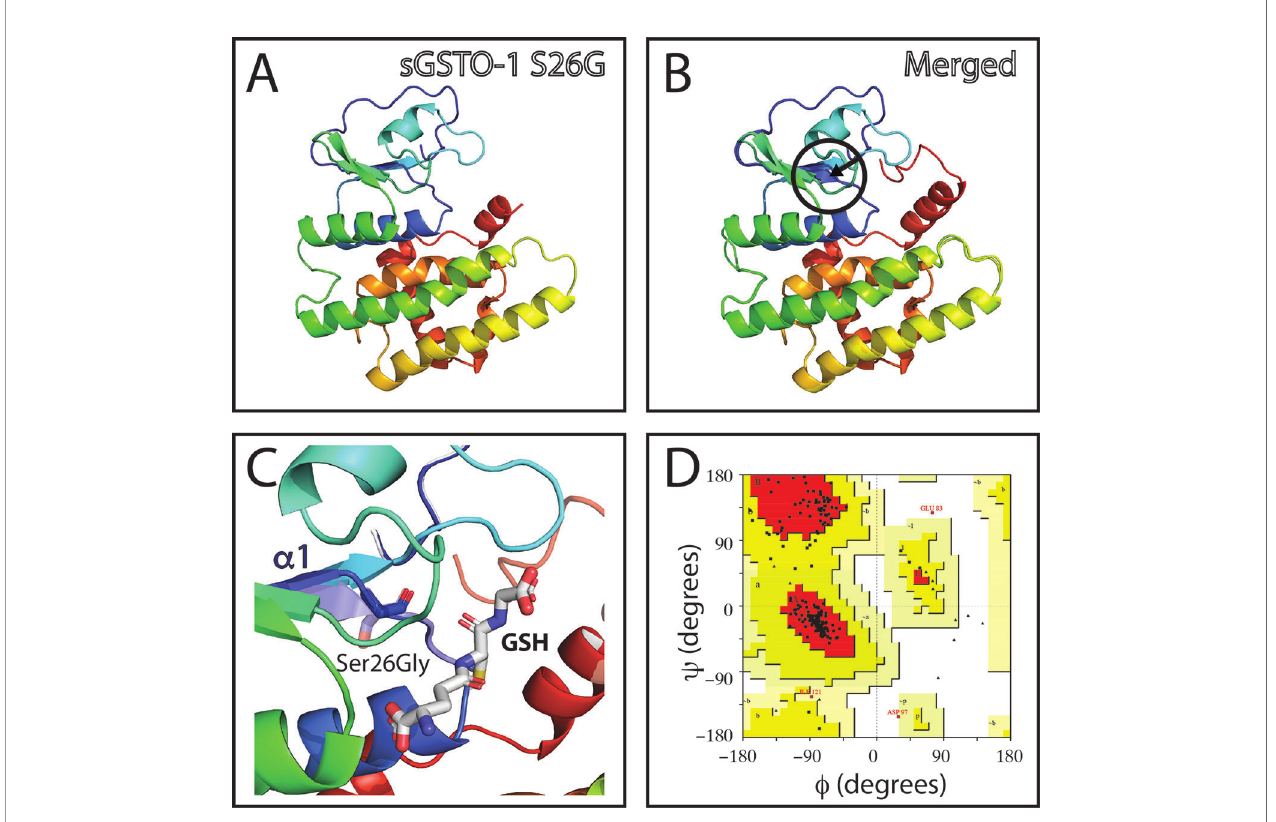
FIGURE 2 | Evaluation of single-nucleotide polymorphism (SNP) c.205A > G effect on the predicted S. salar GSTO-1 (sGSTO-1) structure by homology modeling. (A) Predicted tridimensional sGSTO-1 including the S26G substitution (sGSTO-1 S26G). (B) sGSTO-1 and sGSTO-1 S26P overlay. The punctual amino acid substitution (dotted arrow line) and the region of the secondary structure affected ( b 2 sheet, circle) are indicated. (C) Enlarged view of the sGSTO-1 S26P substitution shown in (B) . sGSTO-1 (transparent) and sGSTO-1 (colored) are shown. The reduced glutathione (GSH) molecule is represented. (D) Ramachandran plot for the predicted sGSTO-1 S26G structure. The amino acid distribution into most favored regions (A,B,L), additional allowed regions (a,b,l,p), generously allowed regions (~a,~b,~l,~p), and disallowed regions (GLU83, ASP97) is